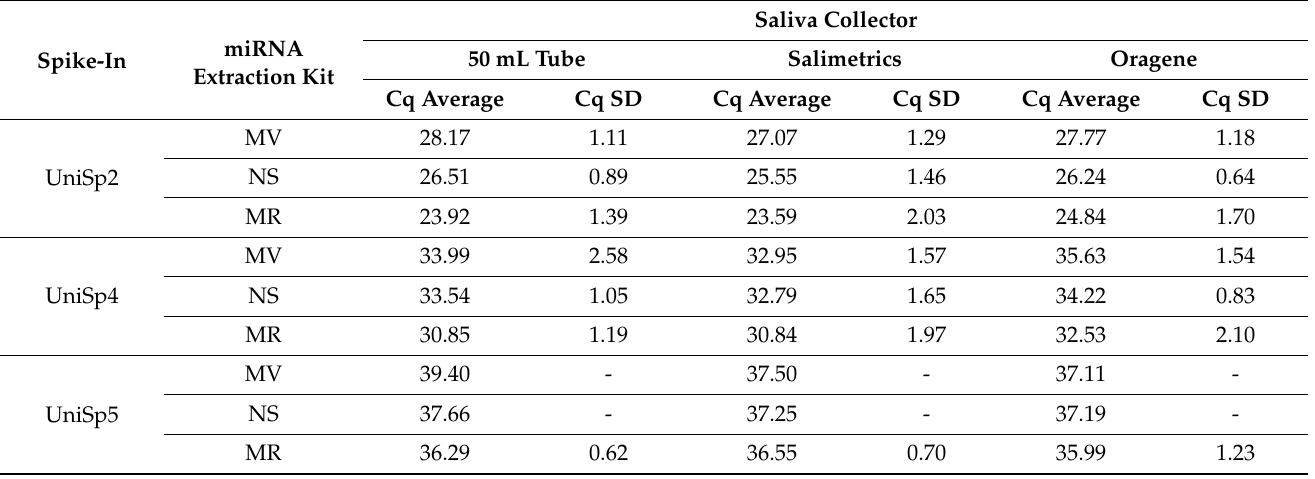
Table 1. Cq values for spike-in 2, 4 and 5 obtained using the different saliva collectors and miRNA extraction kit combinations.